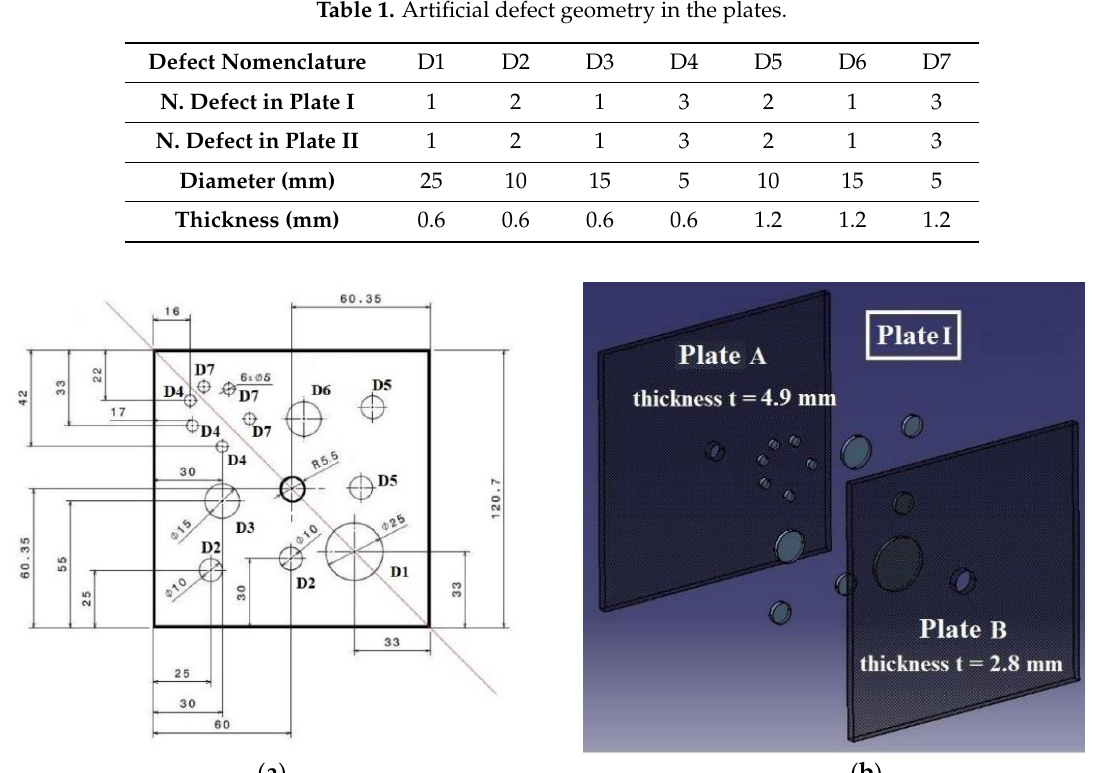
Figure 1. ( a ) Layout of artificial defects and position. ( b ) Exploded Assembly of Plate I, identical for Plate II. Table 2. Mechanical properties of carbon fiber and epoxy